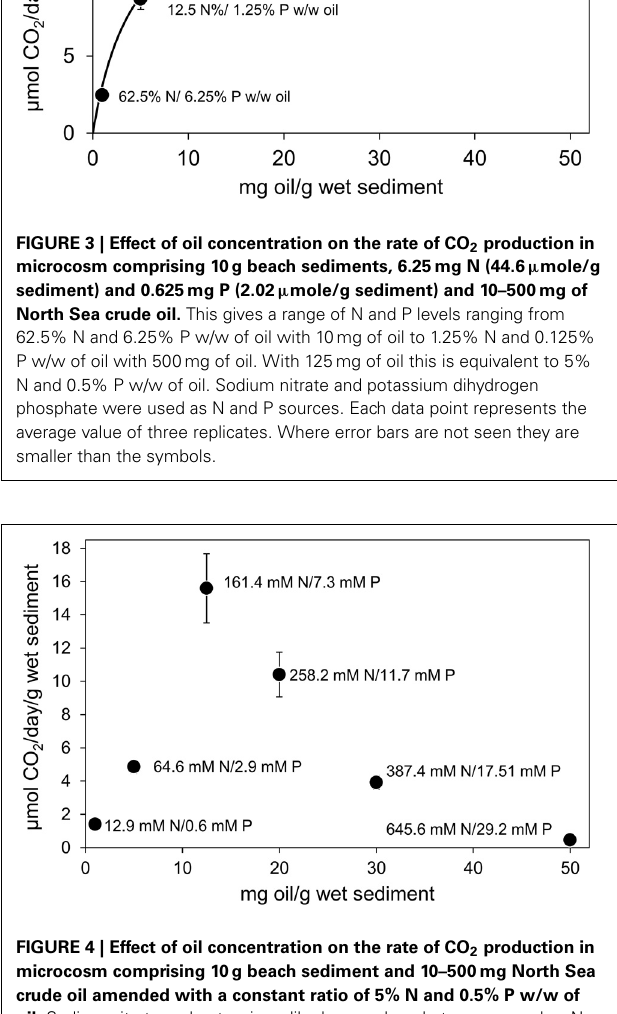
levels of oil. If the microcosm containing 50 mg of oil per